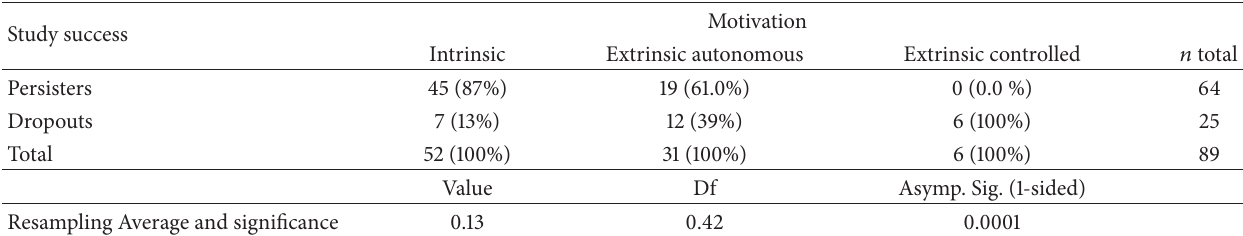
Table 5: The relation between type of motivation and study